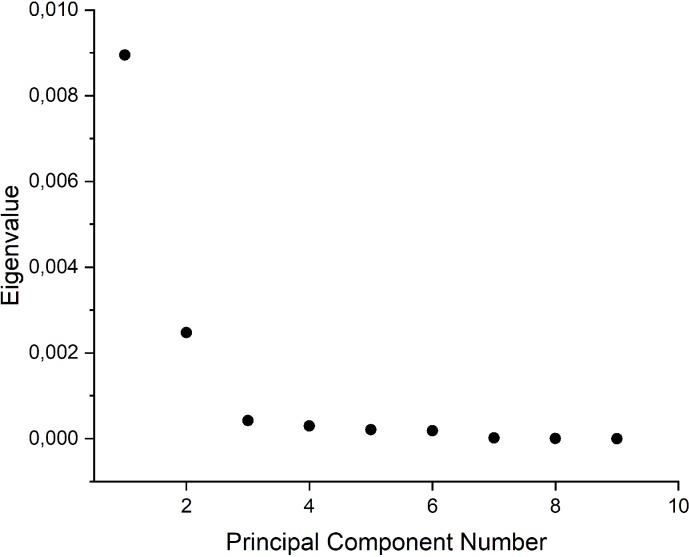
Contribution of eigenvalues with PCs.